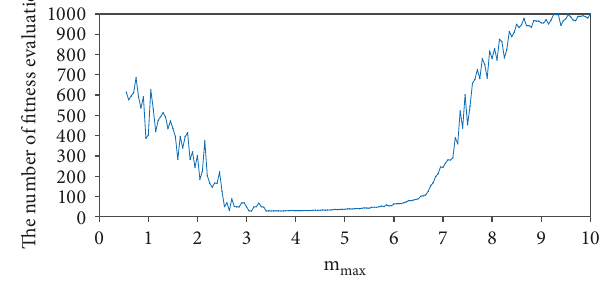
max . 200 particles